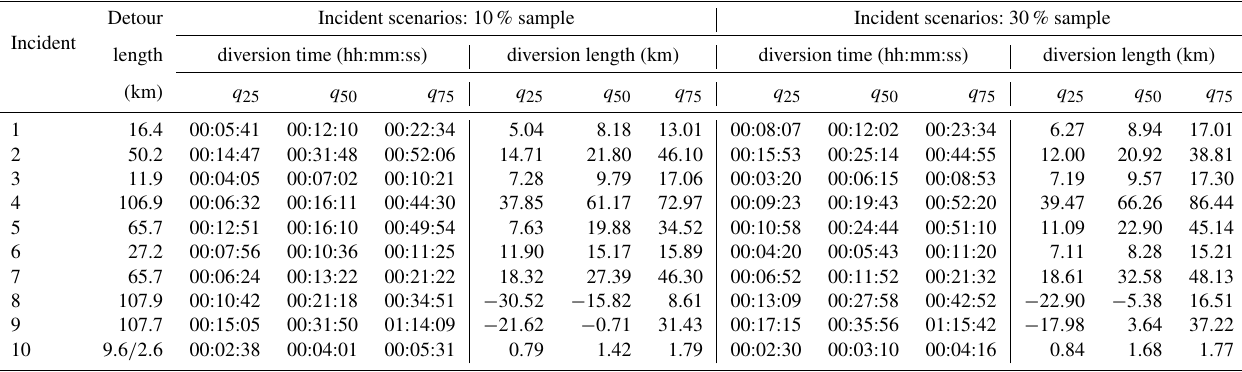
Table 3. Summary statistics of differences between each interruption scenario and the undisturbed baseline scenario, for both (10% and 30%) population samples. They are expressed in terms of quartiles of (additional) diversion lengths and times. For incident site 10, two individual stretches of road are affected (NE–SW); therefore two different detour lengths are